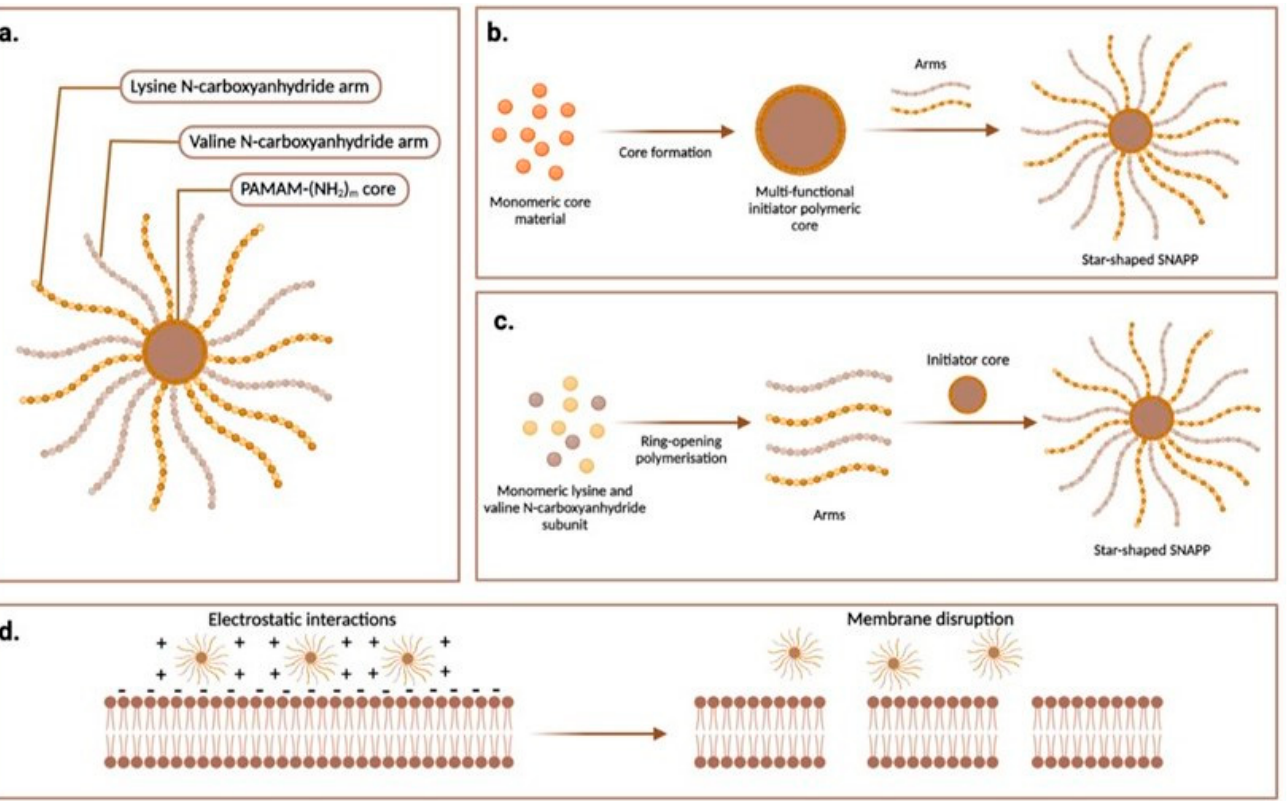
Figure 1. Design features and novel bacterial membrane-specific interactions of structurally nano-engineered antimicrobial polypeptide polymers (SNAPPs): ( a ) Example of a SNAPP co-polymer structure, comprising a multifunctional initiator core of poly(amidoamine) or PAMAM, with m number of lysine or valine N-carboxyanhydride (NCA) polymeric arms complexed to its amino (NH 2 ) terminus. m could be 16 or 32 ( b ) ‘ core-first approach ’ for SNAPP synthesis, involving synthesis of PAMAM core from monomeric amidoamine starting materials followed by the complexing of polymeric lysine or valine NCA arms. ( c ) ‘ Arm-first approach ’ for SNAPP synthesis, involving initial synthesis of the arms by ring-opening polymerisation of monomeric units of lysine or valine NCA. ( d ) Antimicrobial action of SNAPPs involves electrostatic interactions between their negatively charged arms and the positively charged bacterial cytoplasmic membrane, leading to membrane disruption, penetration, pore formation and cell lysis. Figure constructed using the web tool at www.biorender.com.